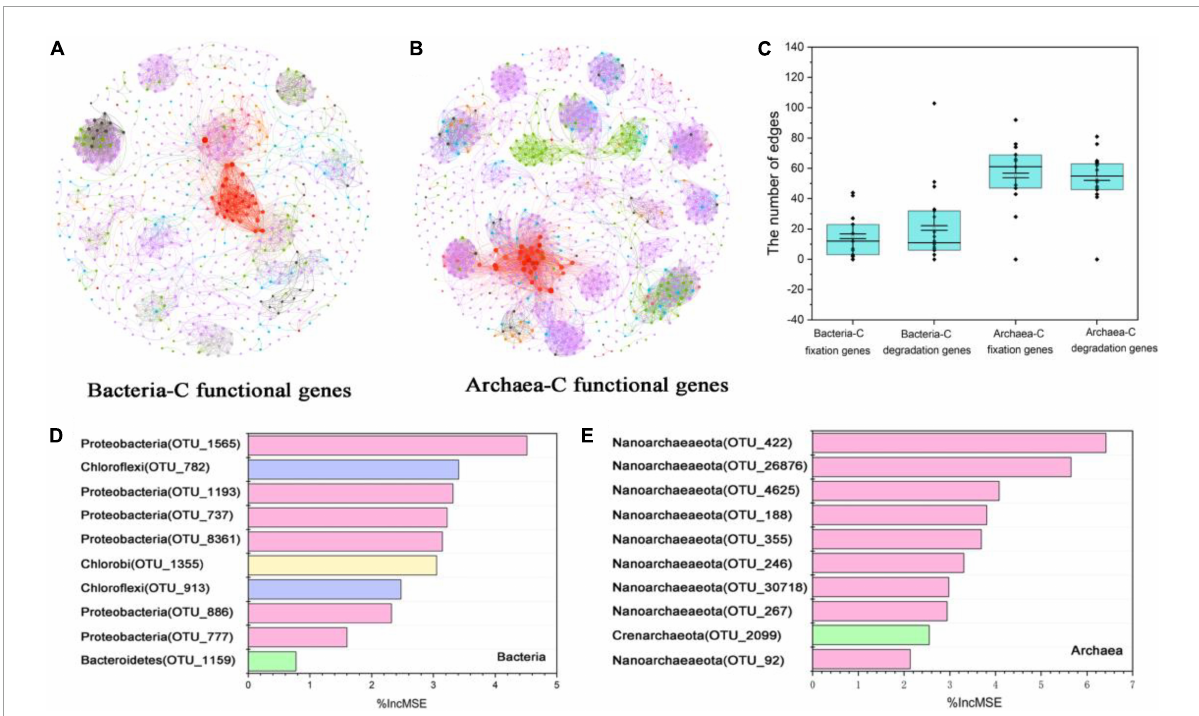
FIGURE5 Co-occurrence networks and Random Forest analysis of microbes and carbon-functional genes. Co-occurrence networks of bacteria and carbon-functional genes (A) ; co-occurrence networks of archaea and carbon-functional genes (B) ; the numbers of edges of microbes (bacteria and archaea) and carbon-functional genes (fixation and degradation genes) based on co-occurrence networks (C) ; Random Forest analysis of bacterial contribution to absolute abundance of carbon-functional genes (D) ; Random Forest analysis of archaea contribution to absolute abundance of carbon-functional genes (E)